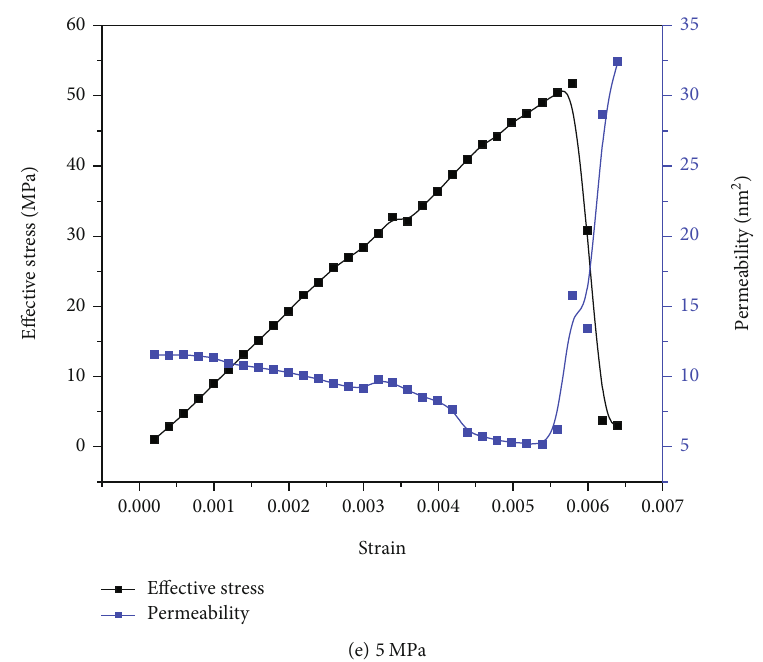
Figure 7: Changes of stress and permeability with strain under di ff erent gas